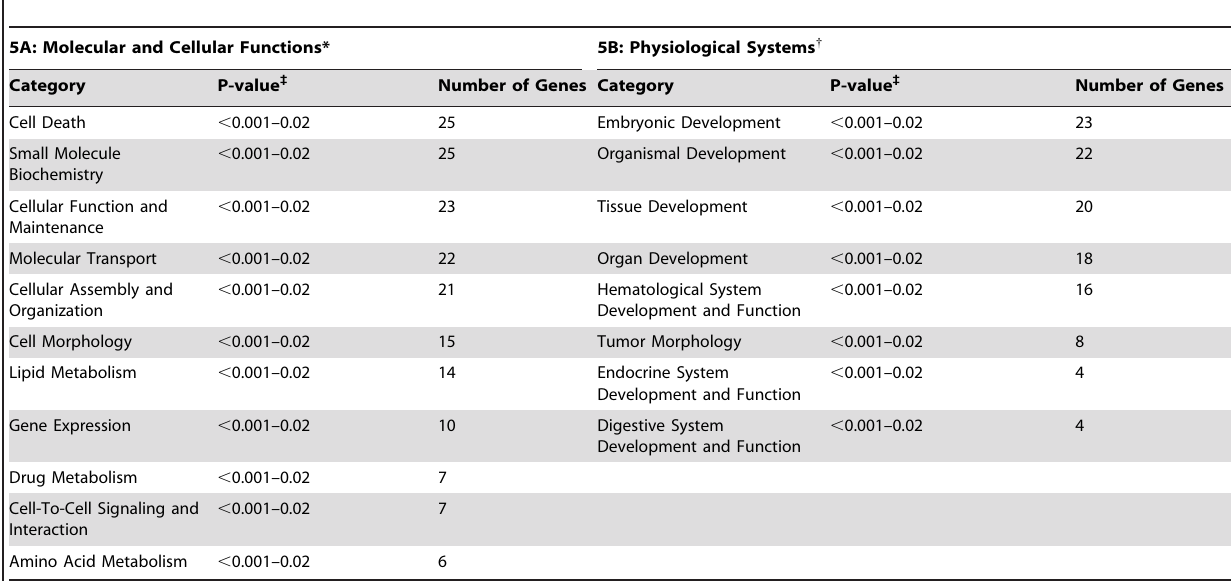
Table 5. Significantly Differentially Regulated Biological Functions and Systems in Fetuses of Obese versus Lean